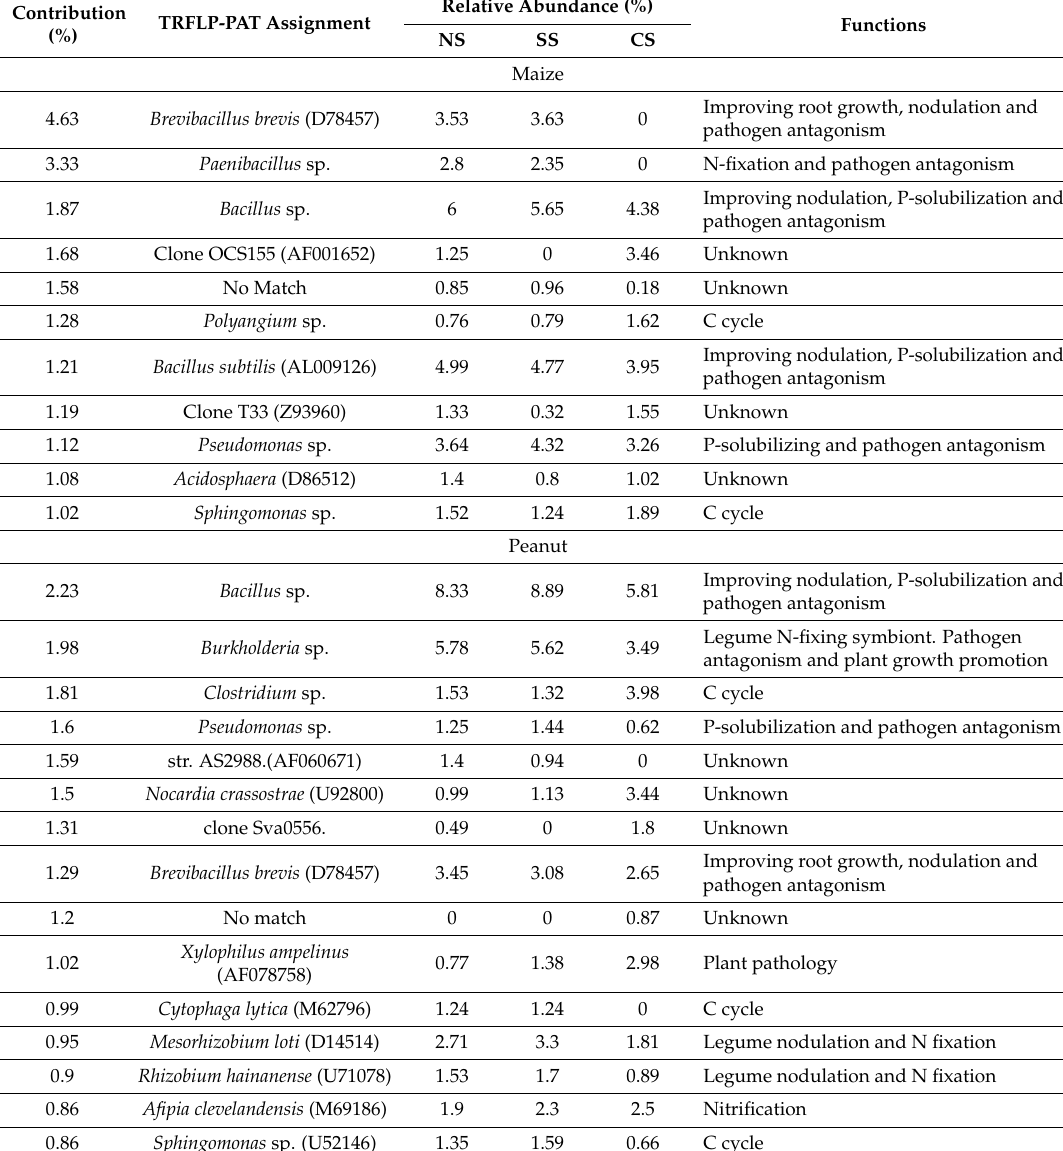
Table 4. Top terminal restriction fragments (T-RFs) with 20% cumulative contribution to the dissimilarity between belowground interaction (NS and SS) and complete separation